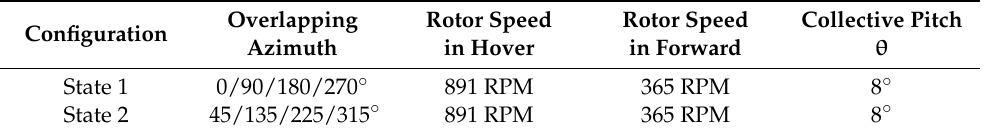
Table 3. Detailed parameters of coaxial helicopter